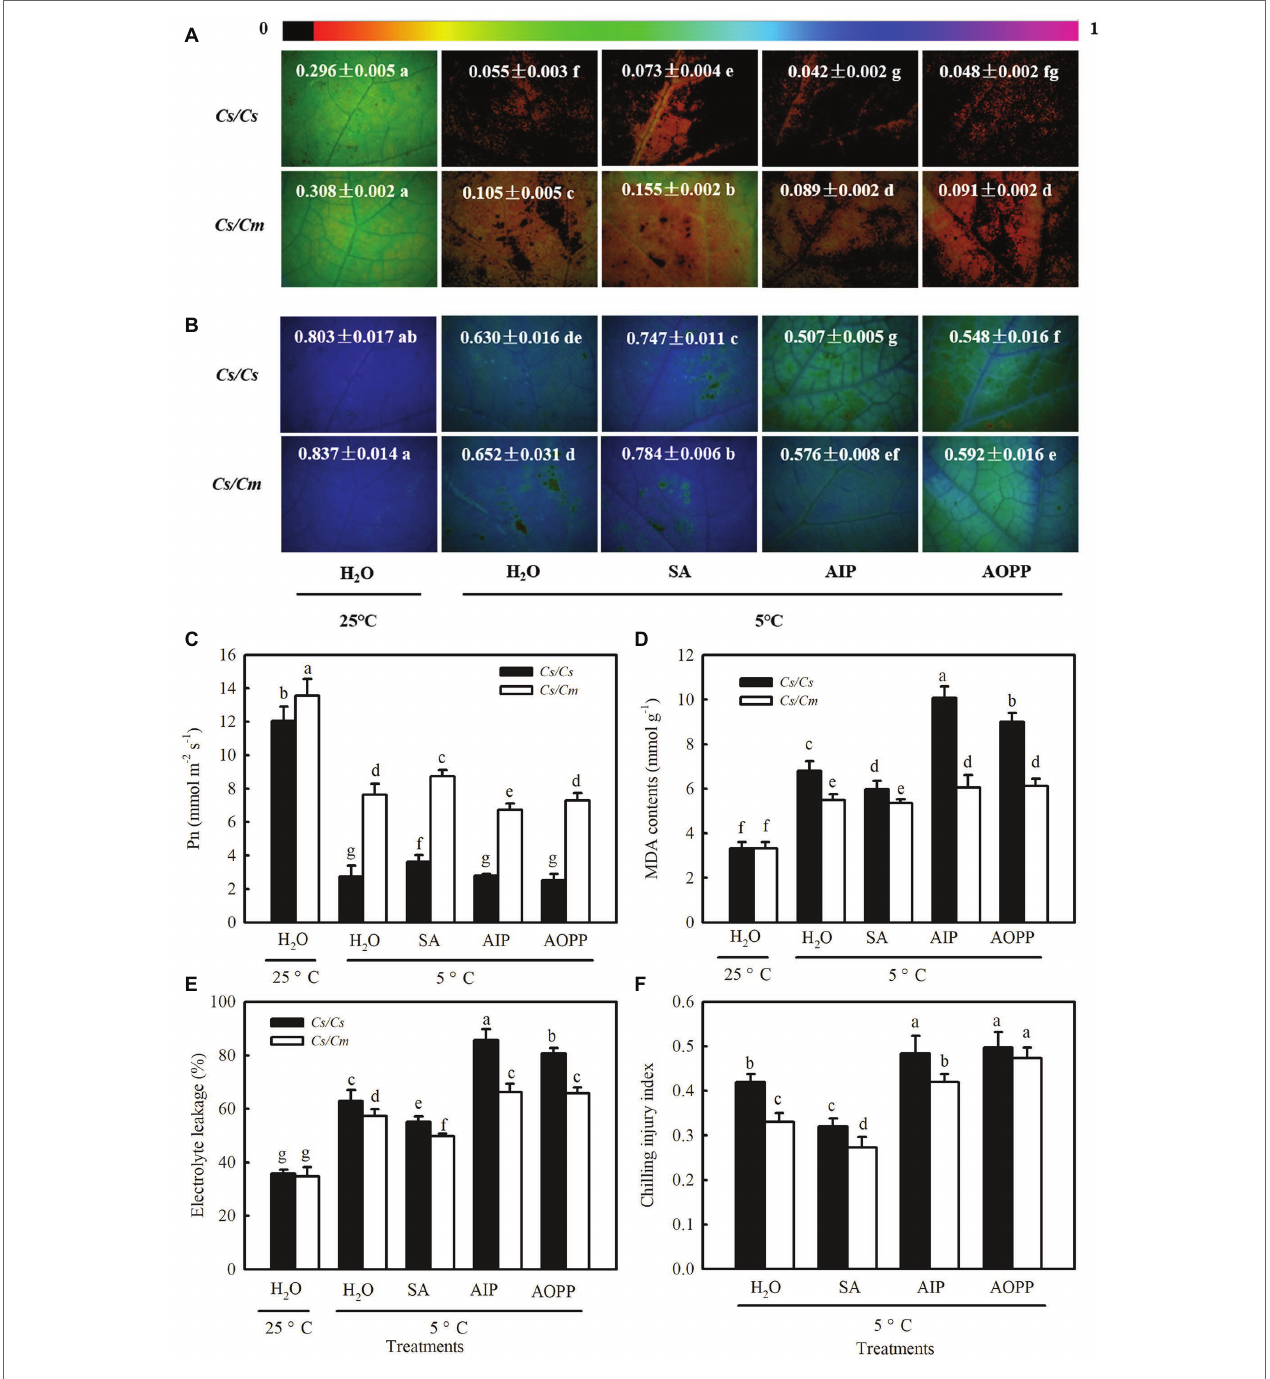
FIGURE 8 | Effect of SA on the chilling tolerance of Cs/Cm and Cs/Cs plants. (A) Φ PSII ; (B) F v / F m ; (C) Pn; (D) MDA content; (E) EL; and (F) chilling injury index (CI). Plants were foliar sprayed with 1.0 mM SA, 0.03 mM AIP, 0.1 mM AOPP, or deionized water (control) for 24 h and then exposed to 5 ° C for 48 h. Data are the means of four replicates (±SDs). Different letters indicate a significant difference between samples according to Duncan’s new multiple range test ( p <